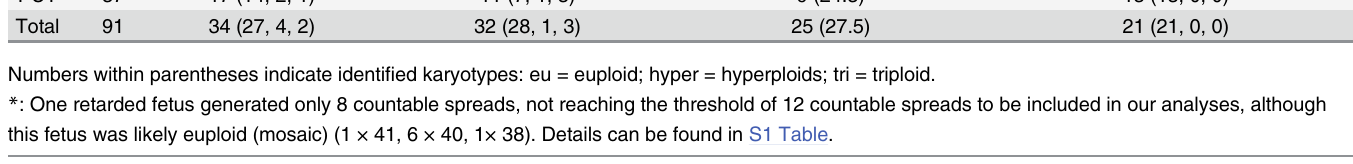
Table 1. Karyotypes of retarded/resorbed fetuses in 10-month-old C57BL/6 mice. Group Total Abnormal implants Normal implants karyotyped (eu, Retarded (eu, hyper, Grade1 resorption (eu, hyper, Grade 2 resorption (% tri) tri)